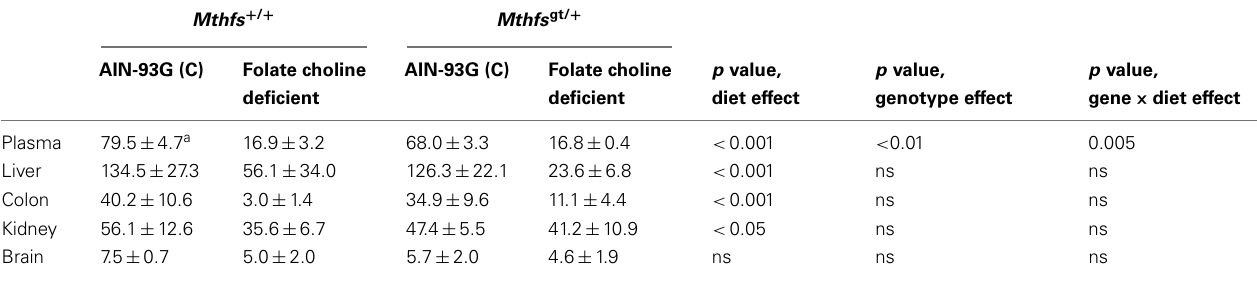
Table 2 | Folate levels of Mthfs + / + and Mthfs gt/ + tissues after 5weeks onAIN-93G andAIN-93G lacking folate and choline.